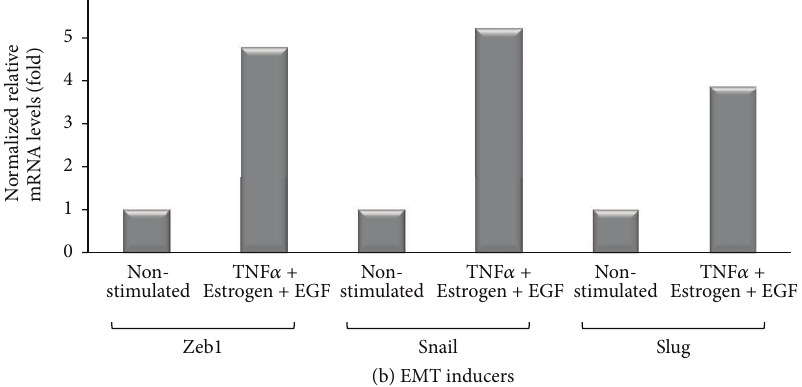
Figure 7: Combined stimulation by TNF 𝛼 + Estrogen + EGF leads to acquisition of mesenchymal phenotype by the tumor cells, and to upregulation of EMT inducers. Breast tumor cells were stimulated by TNF 𝛼 + Estrogen + EGF (concentrations as in Figure 1) for three days. Non-stimulated: cells grown with the diluents of the above factors. (a) Cell morphology was determined by light microscopy at × 20 magnification. (a1) Non-stimulated cells. (a2) Cells stimulated by TNF 𝛼 + Estrogen + EGF. Arrows point to some of the cells that have undergone remodeling in response to TNF 𝛼 + Estrogen + EGF stimulation. In all panels, the results are from a representative experiment of 𝑛 ≥ 3 . (b) Expression of the EMT inducers Zeb1, Snail, and Slug in cells stimulated by TNF 𝛼 + Estrogen + EGF and in non-stimulated cells (grown with the diluents of the factors), determined by qPCR analysis. In all panels, the results are from a representative experiment of 𝑛 ≥ 3 .